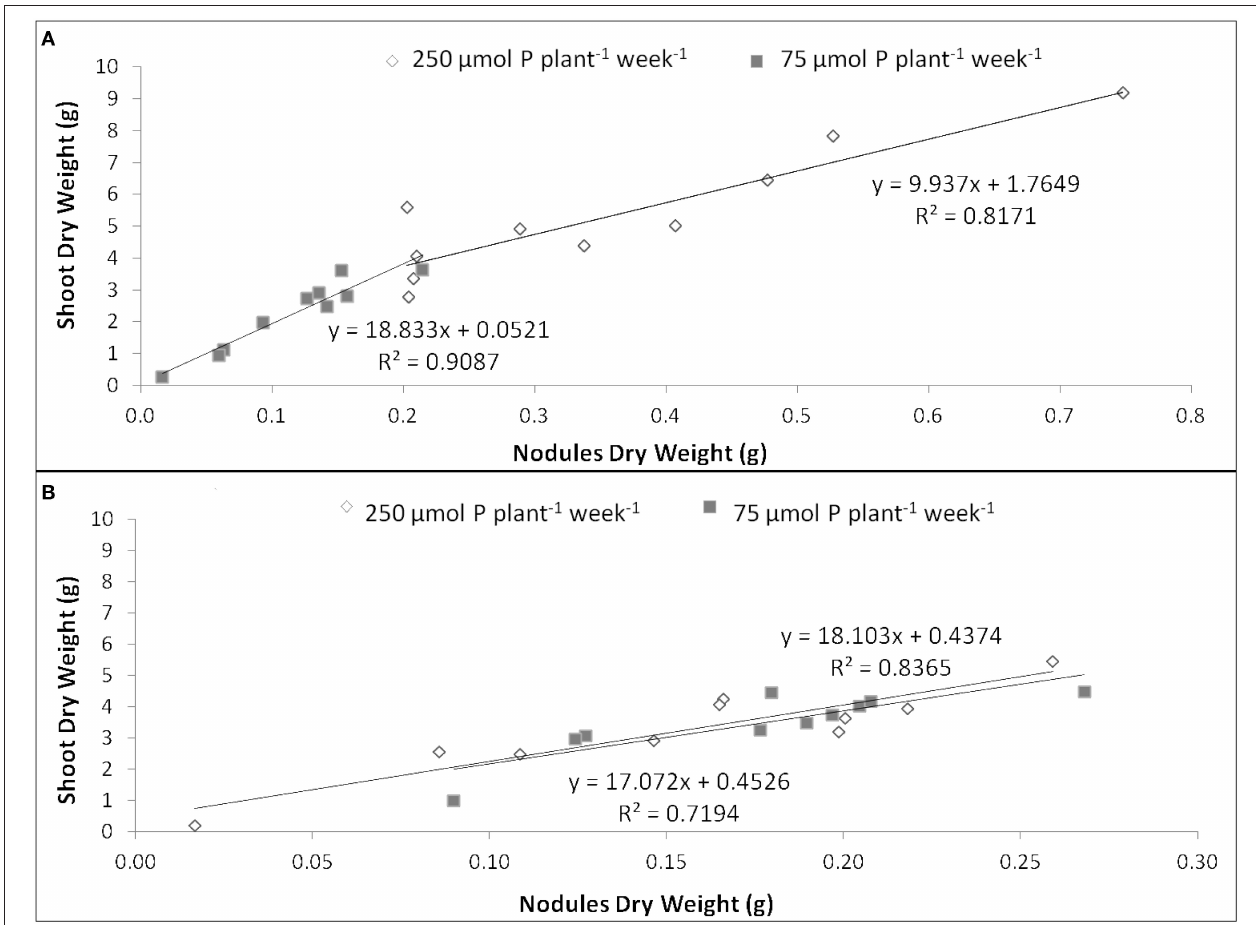
FIGURE 3 | Efficiency in use of the rhizobial symbiosis (EURS) in G. max cultivars N5909 (A) and SR532 (B) under P sufficiency (250 µ mol P plant − 1 week − 1 ) (white) vs. P deficiency (75 µ mol P plant − 1 week − 1 ) (gray). Data are individual values harvested at 42 DAT.